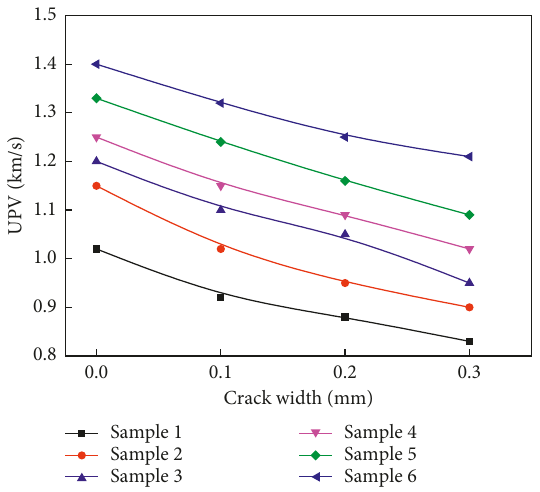
Figure 11: Variation of UPV with crack